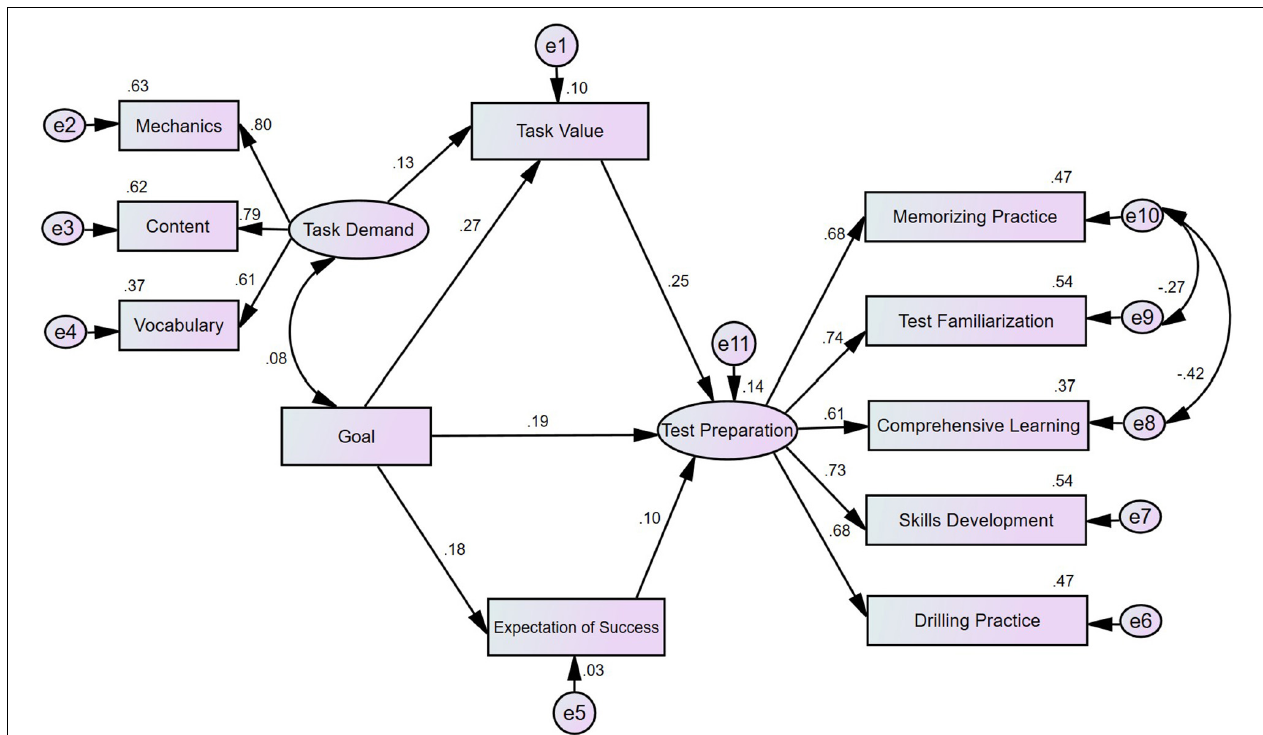
FIGURE 3 | Final model with standardized parameter estimates.